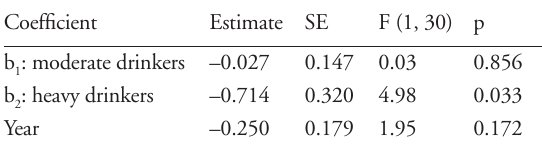
Table 1. Breakpoint GLM (general linear model) re-analyzing Grim’s (2008) Fig. 1 data testing for a relationship between beer consumption and publication output. The coefficient for the slope of the regression line in heavy drinkers would be the sum of b and b , however, because b is not significantly different from 1 2 1 zero, the slope for heavy drinkers is just b (Neter et al. 2